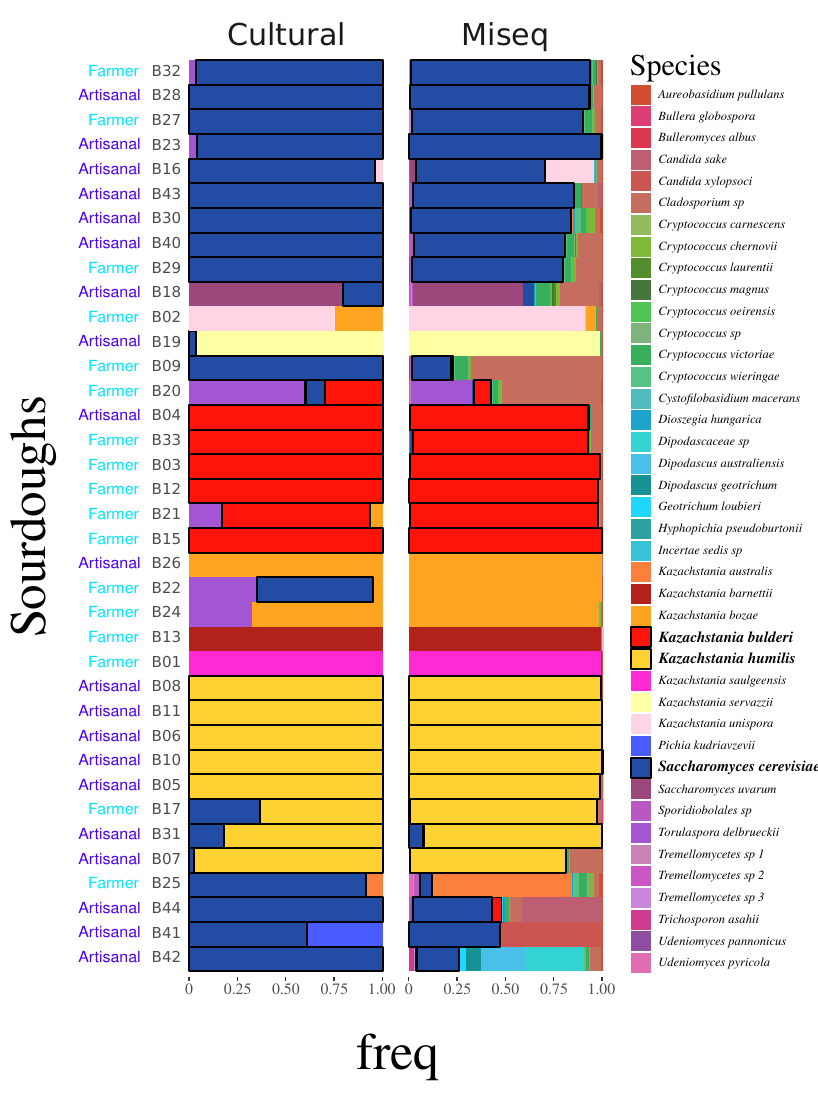
Figure 3: Fungal species diversity was analyzed for 38 out of the 39 sourdoughs with both cultural and metabarcoding methods. Left: species were identified by traditional microbial isolation and identification using ITS sequencing. Right: species were identified using ITS1 metabarcoding. The three most frequently-encountered species are shown in contrasting colors surrounded by black (blue: Saccharomyces cerevisiae , red: Kazachstania bulderi , yellow: Kazachstania humilis ). The bread making practice of the bakers who supplied the sourdough is indicated on the left (“artisanal” in purple, “farmer” in light blue). We then analyzed specifically the occurrence of yeast species in sourdoughs as yeasts, together with lactic acid bacteria, are the main functional players in a sourdough ecosystem and for bread quality (Figure 4). Over the 40 yeast species detected in the 38 sourdoughs, 12 had a relative abundance over 50% in at least one sourdough, four had a relative abundance between 20% and 50% and 24 had a relative abundance below 10%. All dominant species (relative abundance over 50%) were fermentative yeast species, except in one sourdough that had a C ladosporium species as co-dominant species. We found all the sourdough yeast genera ( Saccharomyces , Kazachstania , Pichia , Torulaspora and Hyphopichia) commonly reported in the literature except the Wickerhamomyces genus that we did not detect in our samples [1, 15,